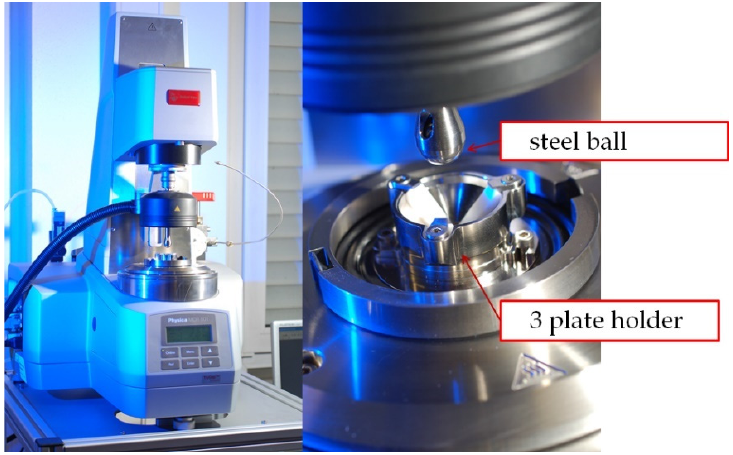
Figure 6. Tribological testing set-up: ball-on-plate after cutting out of specimen (exemplary specimen plates).